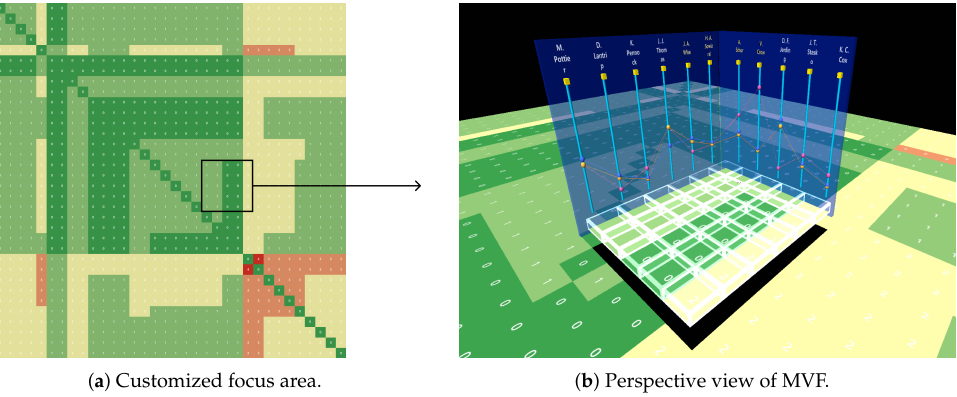
Figure 1. Multivariate Fence—A focus view model for adjacency matrix showing node